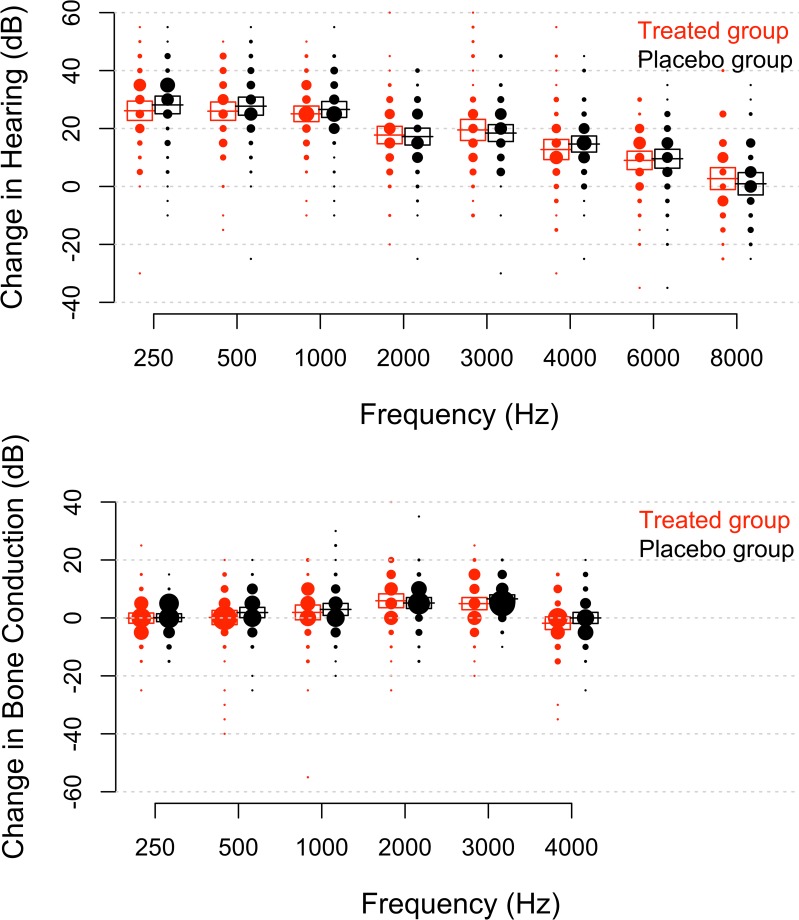
(Upper graph) Change in hearing thresholds 6 weeks after surgery (as compared to measurements before the operation).Hearing was measured at the same set of frequencies as in Fig. 2. The size of each dot corresponds to the number of patients, obtained from the histogram for each frequency (5 dB bins) and boxes enclose the 95% confidence interval. Horizontal lines show the mean value at each frequency. One patient with complete sensorineural hearing loss after surgery is omitted from the plot (but included in all statistical analyses). (Lower graph). Change in bone-conduction thresholds at 6 weeks. The scaling of the dots is the same in both panels.